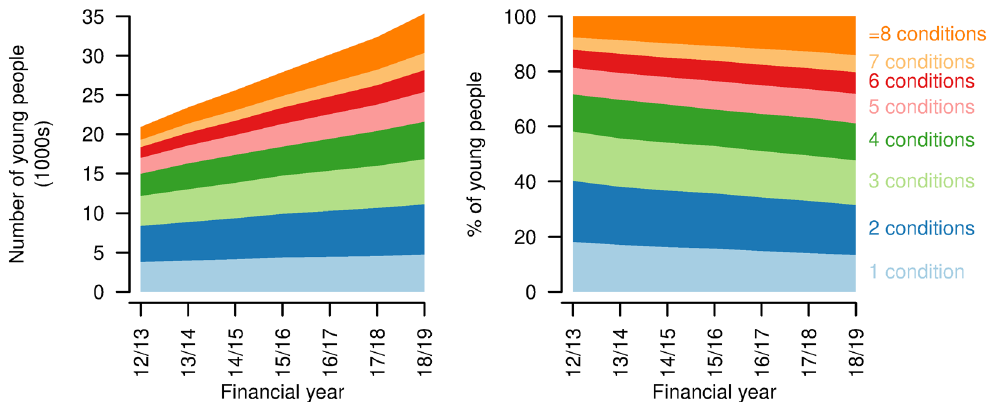
Figure 6. Numbers of chronic conditions for young people aged 14–19 years with a life-limiting condition. Numbers (left) and proportions (right) of young people aged 14–19 years with a life-limiting condition having different numbers of chronic condition categories recorded, by year.